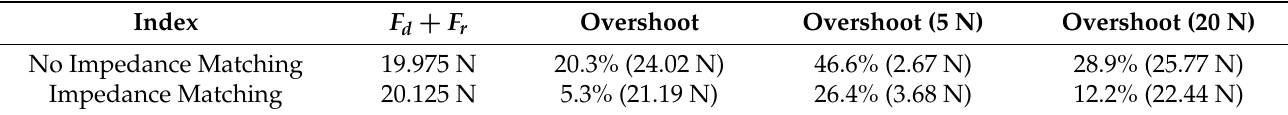
Table 3. Analysis of experimental results of impedance control.